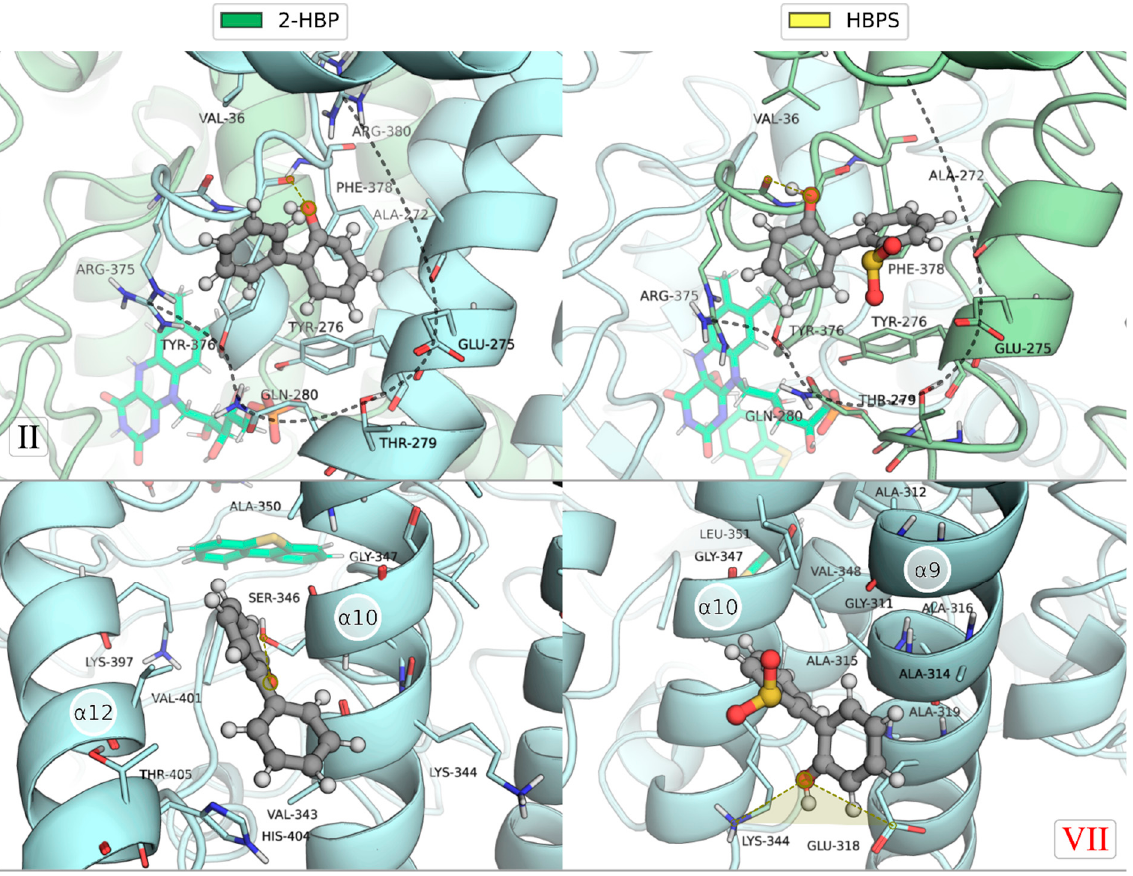
Figure 5. Representative binding mode of 2-HBP and HBPS at the binding sites II (on top) and VII (on bottom). 2-HBP and HBPS are represented in ball-and-stick representation with carbons colored in gray. All residues composing the binding pocket and those within 4 Å of 2-HBP and HBPS are represented in stick representation. Residues within 4 Å of either 2-HBP and HBPS are labeled. Each monomer of DszC is represented in cartoon and colored green (chain A) or cyan (chain B). Hydrophobic patches are outlined with dashed gray lines, and hydrogen bonds are represented with dashed green lines.